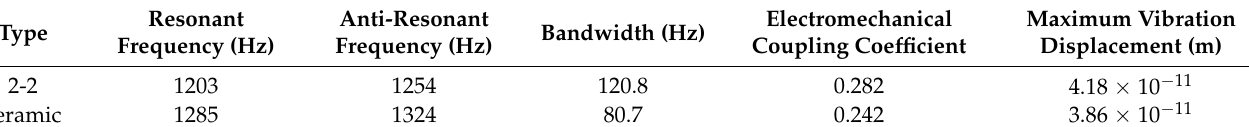
Figure 11. The vibration mode diagram of the trilaminar vibrator: ( a ) 1/4 period; ( b ) 2/4 period; ( c ) 3/4 period; ( d ) 4/4 period. Table 4. The average piezoelectric parameters of the 2-2 and ceramic vibrators.